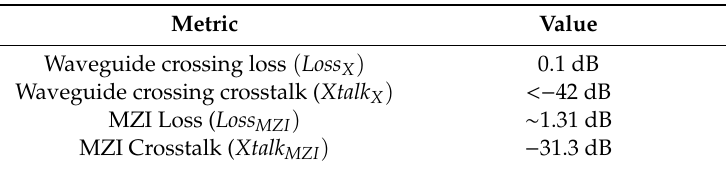
Table 5. Best component performances.